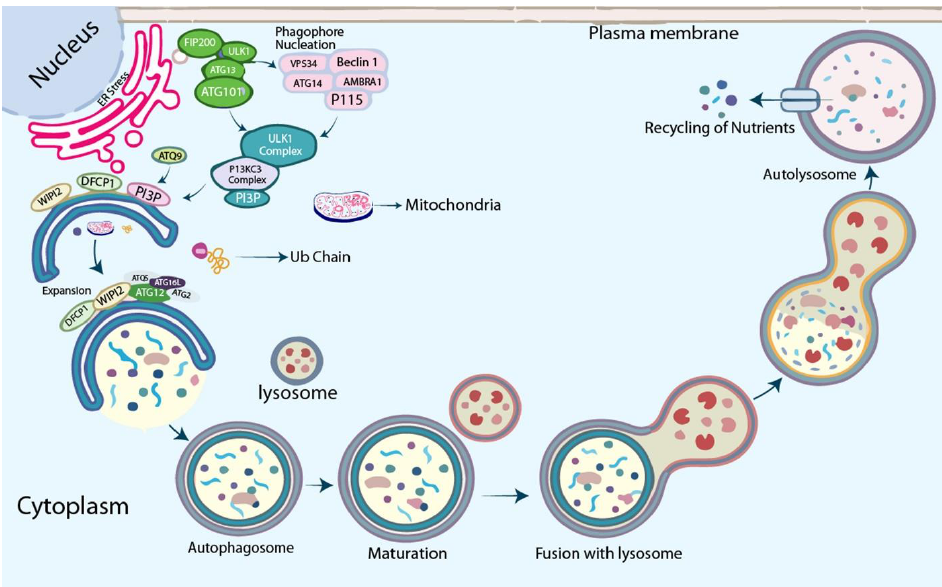
Figure 1. Graphical model illustrating the interaction between ER stress and autophagy. Multiple conditions, such as increased ER stress, oxidative stress, starvation, hypoxia, and protein aggregation, activate AMPK. AMPK initiates the autophagy process by dephosphorylating mTORC1 and activating ULK. Further, the ULK/ATG13/FIP200 complex is necessary for inducing autophagy because these proteins regulate autophagy by increasing mTORC1 phosphorylation. Additionally, ULK acts in conjunction with FIP200 and ATG13 to produce a complex that phosphorylates Beclin 1, resulting in VPS34 activation and phagophore assembly, then activates nucleation of the phagophore by phosphorylating class III PI3K (PI3KC3). PI3P draws the PI3P effector proteins WIPI2 and DFCP1 (zinc-finger FYVE domain-containing protein 1) that interact with their PI3P-binding domains. WIPI2 directly binds with ATG16L1 and recruits the ATG12~ATG5–ATG16L1 complex enhancing the ATG3- mediated conjugation of ATG8 family proteins (ATG8s), essential for elongation and closing of the phagophore membrane. Next, acidic hydrolases in the lysosome break down the autophagic cargo, and reclaimed nutrients are transferred to the cytoplasm for reuse by the